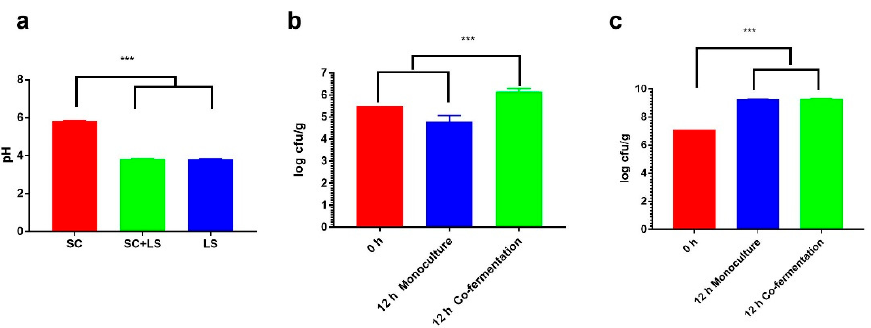
Figure 1. The pH values ( a ) and changes in microbial population of S. cerevisiae 9Y3 ( b ) and F. sanfranciscensis LS1 ( c ) in sourdoughs under monoculture and co-fermentation conditions. (*** p < 0.001), SC: S. cerevisiae 9Y3; LS: F. sanfranciscensis LS1.